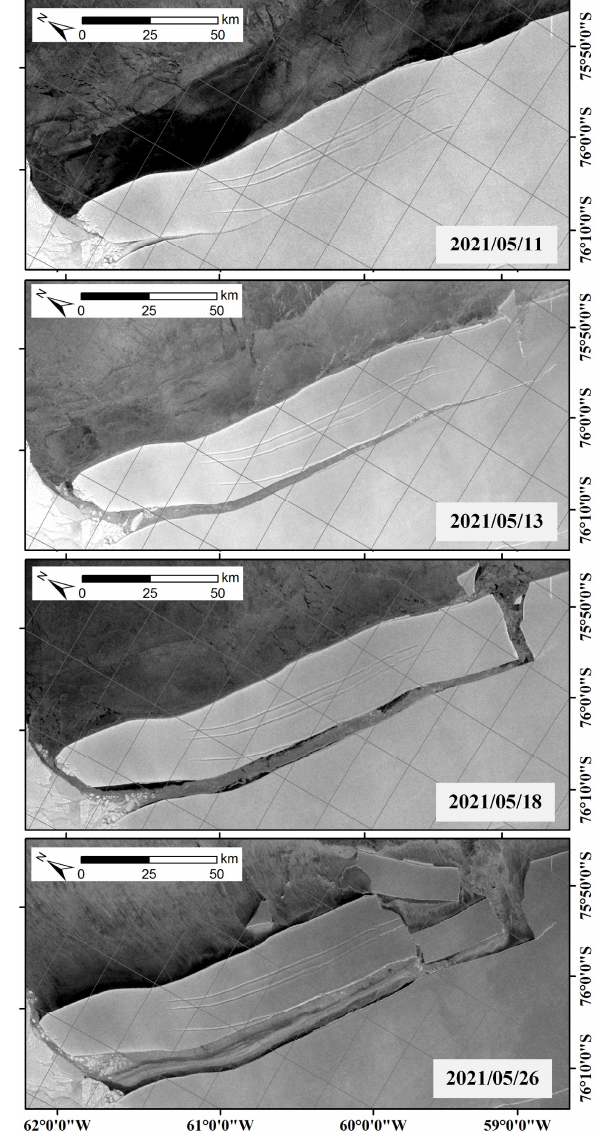
Figure 7. The RIS front area before (a), and after (b), (c) and (d), the detachment of the iceberg in May 2021. Figure 8 depicts the drift trajectory of each iceberg. The extracted centroids and Eulerian paths are color coded, with blue indicating the centroid of the extracted A-76 iceberg and the corresponding blue solid line. From May 14, 2021 to May 25, 2021, the A-76 iceberg is relatively stable, and moving at an average speed of 0.89 km/d. The A-76A, A-76B, and A-76C icebergs are represented by the orange, light blue, and green, respectively.